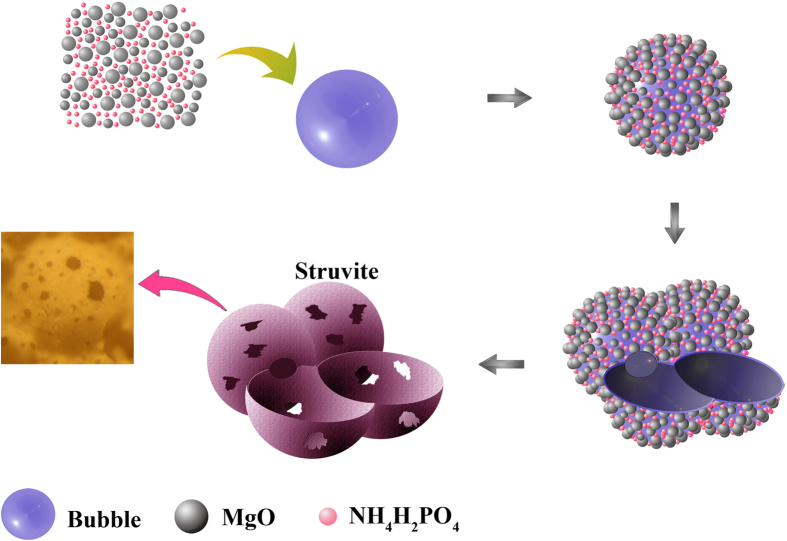
SEM of HPMPP with different S/So ratios(a) 0.02, (b) 0.06, (c,d) 0.10.